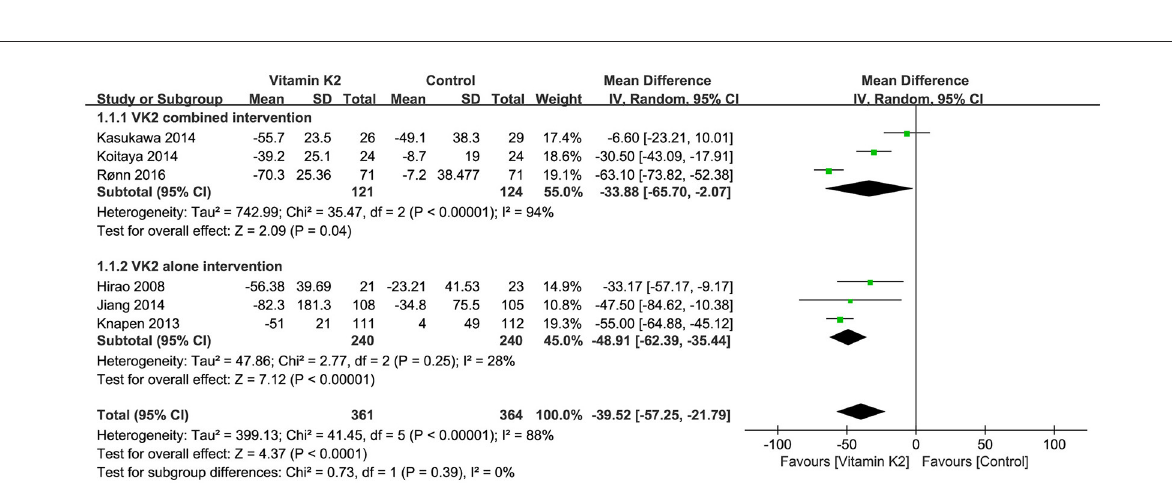
FIGURE8 Forest plot of the change in serum uc-OC.